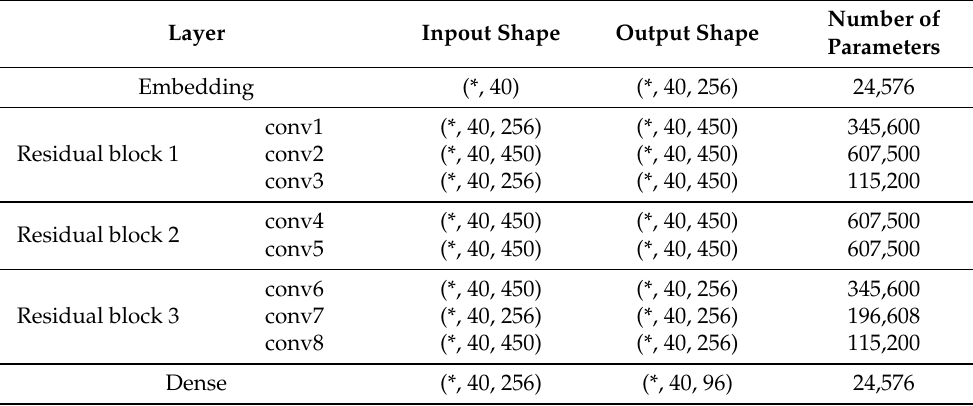
Table 3. The network architecture and number of parameters in each layer. Layer